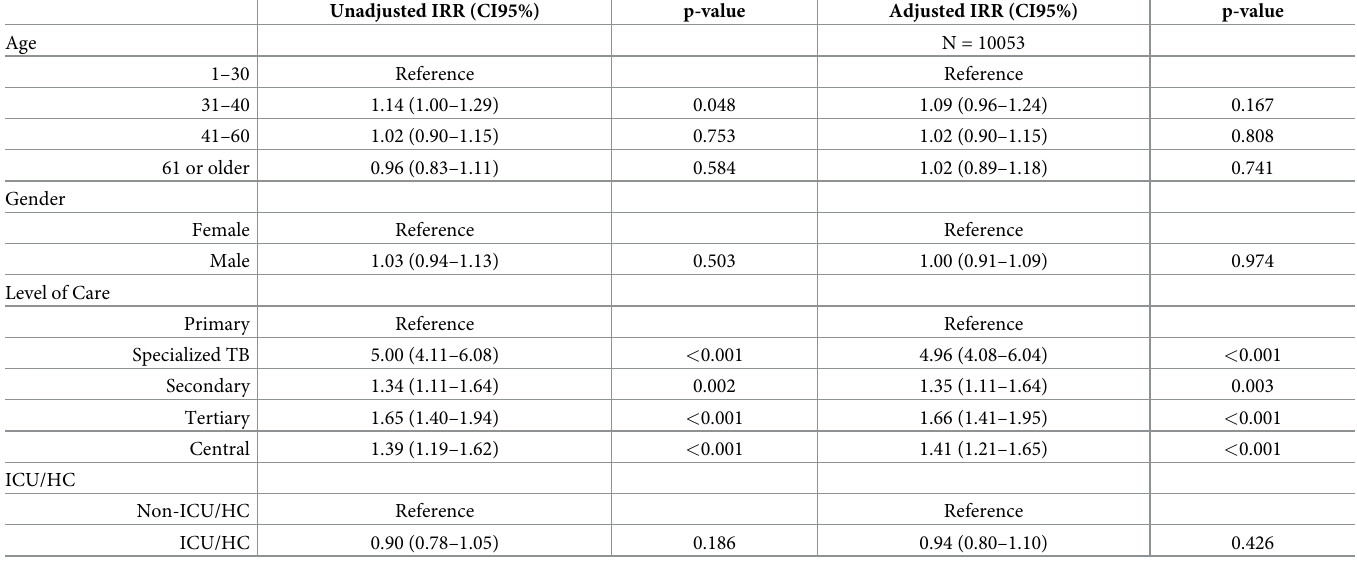
Table 4. Unadjusted and adjusted incidence rate ratios for factors associated with